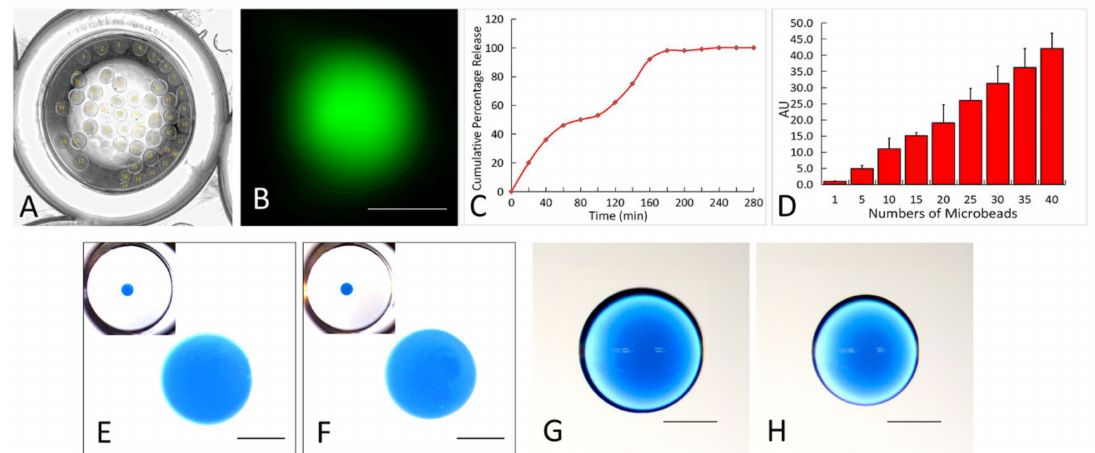
Figure 2. ( A ) Demonstration of the high-throughput assay. A representative phase contrast image of 40 alginate beads within a well of a 96-well plate. The beads were directly dispensed and formed within the well. ( B ) A representative fluorescent image of FITC-dextran releasing from an alginate bead within a well of a 96-well plate. ( C ) The accumulative percentage release curve of the FITC-dextran from the alginate beads. ( D ) The dose-release curve of the FITC-dextran incorporated alginate beads. All data were normalized to the amount of FITC-dextran released from a single bead. ( E – H ) Representative images of droplets of blue dextran-incorporated alginate, with high (F and H) and low ( E , G ) viscosities, which were dispensed into the CaCl 2 solution ( E , F , the images at the upper left corners are the global view of an entire well in a 96-well plate and the images in each center show the zoomed-in views) and Petri dish surface ( G , H ). The droplet with high viscosity ( H ) demonstrates smaller diameter than the low viscosity one ( G ) on the Petri dish surface. Each scale bar is 500 µ